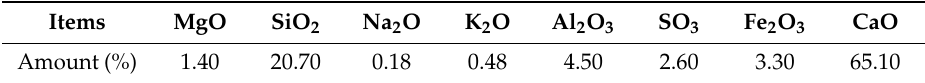
Table 2. Characteristics of the